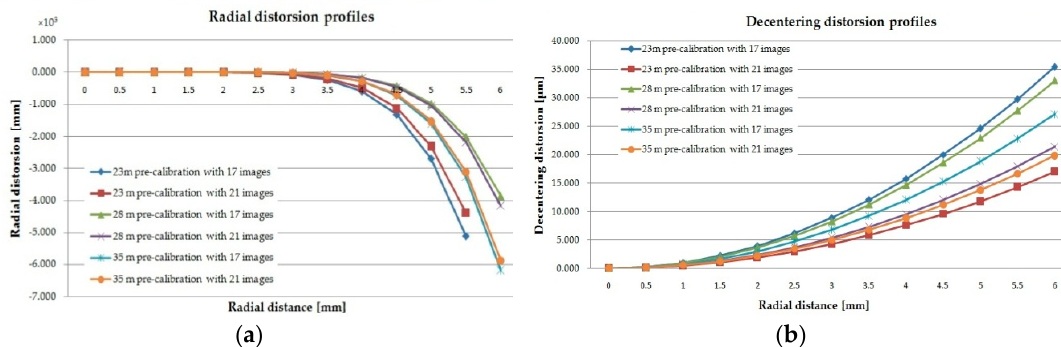
Figure 10. ( a ) Radial and ( b ) decentering distortion profiles for the digital camera mounted on “DJI Phantom 3 standard” UAS at 23, 28, and 35 m height for 17 oblique images and 21 oblique and nadiral images.